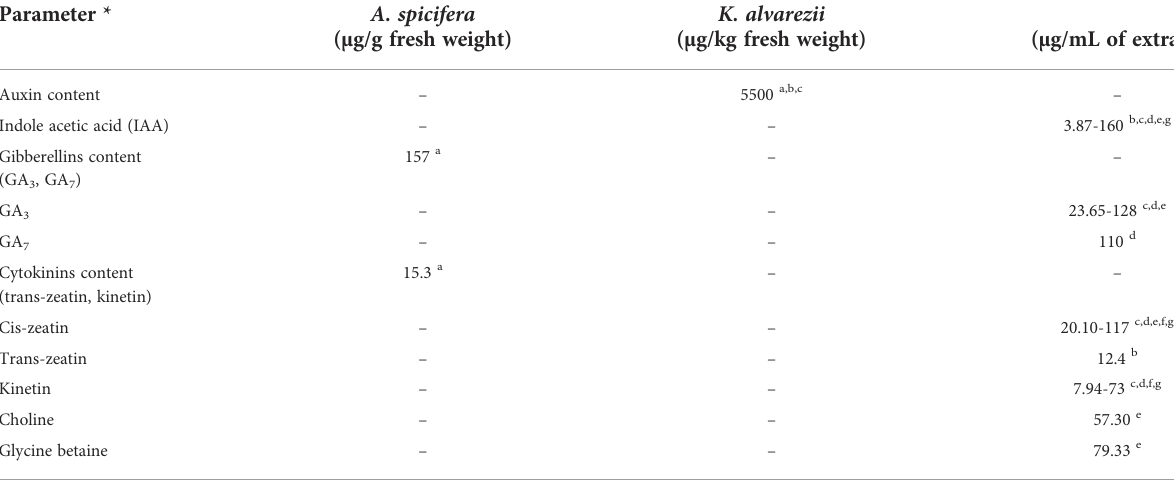
TABLE 4 Phytohormone content in A. spicifera and K. alvarezii.